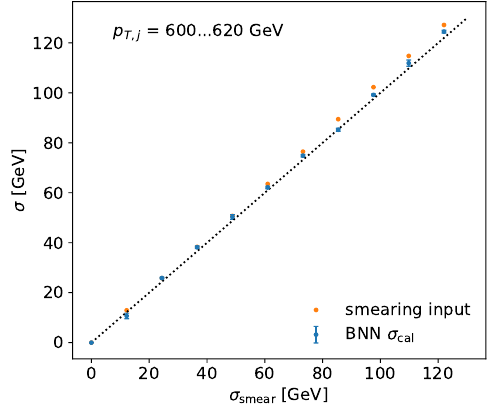
Figure 10: Correlation between σ , as given by the Bayesian network and the stoch smearing σ applied to the label in the training data. The baseline σ smear defined as σ in the limit of no smearing. The error bars indicate the standard stoch deviation from five independent trainings.